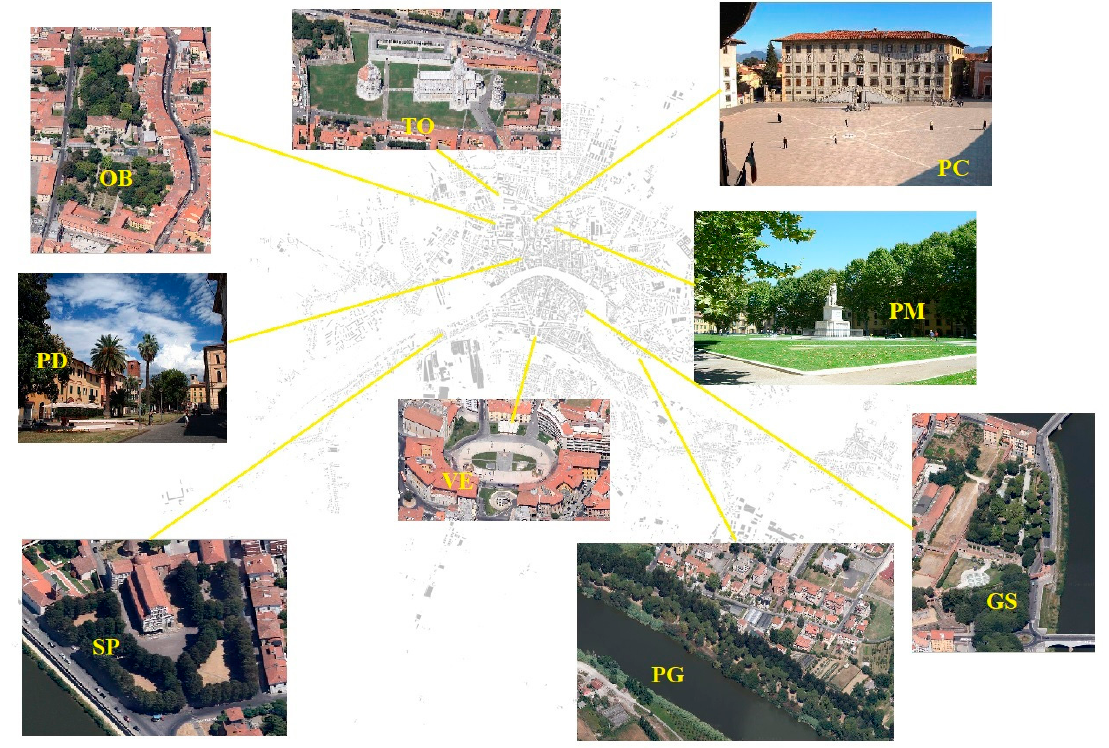
Figure 1. Map of Pisa with the surveyed area. GS: Giardino Scotto; OB: Orto Botanico; PC: Piazza Cavalieri; PD: Piazza Dante; PM: Piazza Martiri della Libertà; TO: Piazza dei Miracoli; SP: San Paolo; PG: Piagge; VE: Piazza Vittorio Emanuele.